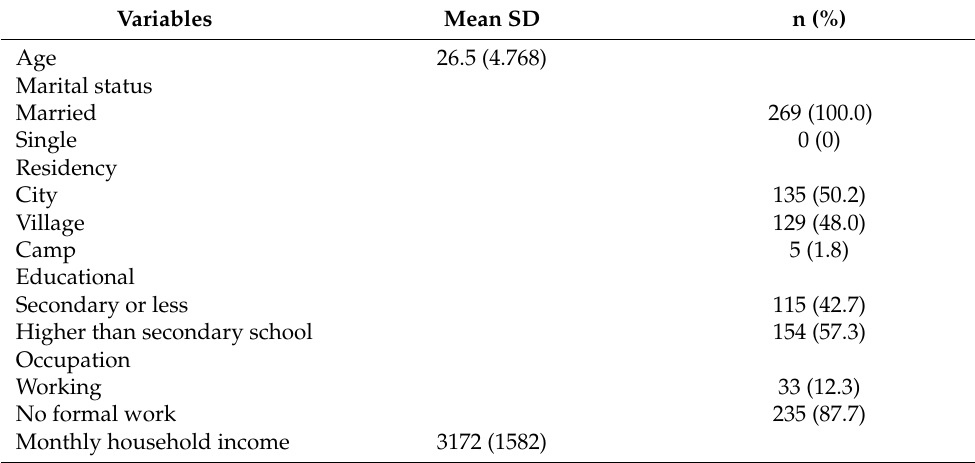
Table 2. Socio-demographic characteristics of the participants (n = 269).